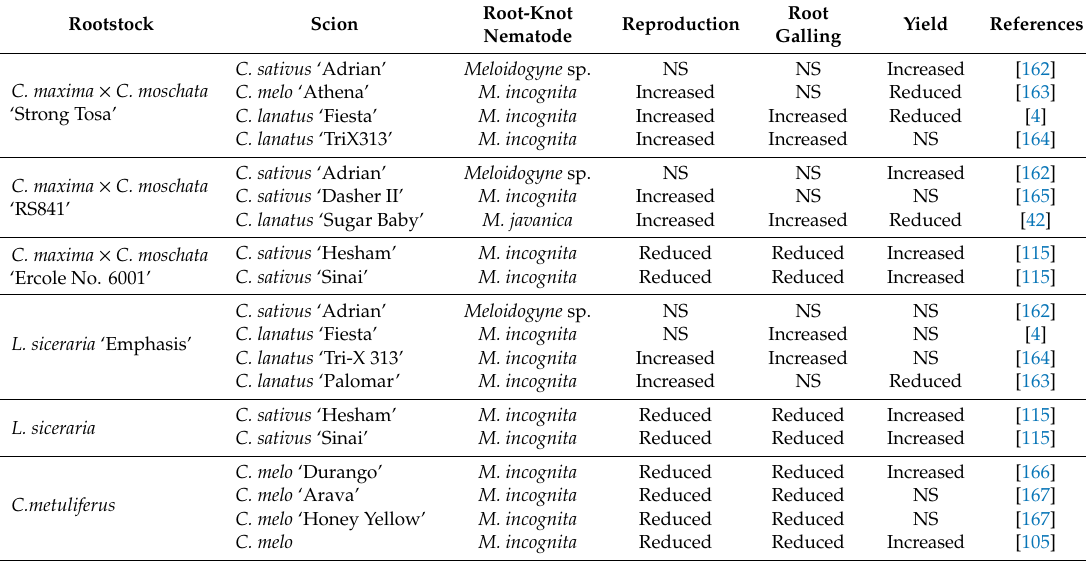
Table 4. E ff ect of grafting cucumber, melon, and watermelon onto squash hybrid ( Cucurbita maxima × Cucurbita moschata ), Lagenaria siceraria , and Cucumis metuliferus rootstocks in comparison to ungrafted plants on disease severity (root galling), nematode reproduction traits, and crop yield in root-knot nematode-infested